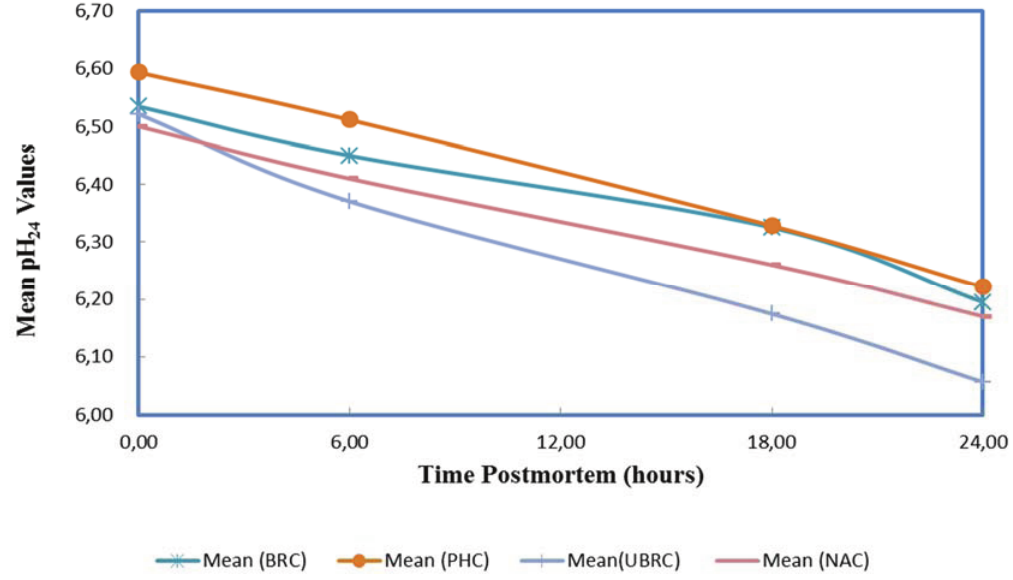
Figure 3. Mean pH of meat against time postmortem for poorly-handled cattle (PHC), non-ambulatory cattle (NAC), bruised carcasses (BRC), and unbruised carcasses (UBRC).